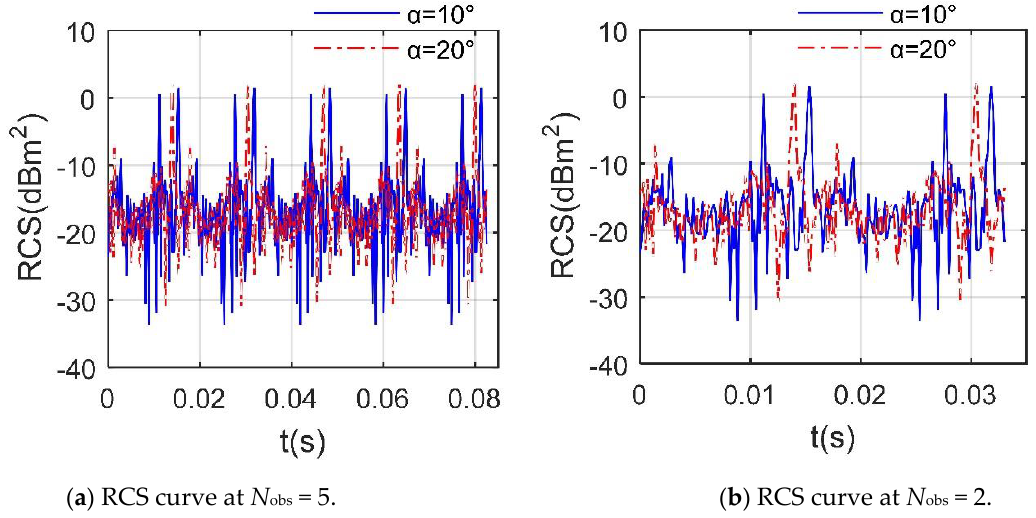
Figure 7. Periodic characteristics of dynamic RCS of rotor 1, f RH = 10 GHz, β = 5°, n r1 = 1200 r/min.